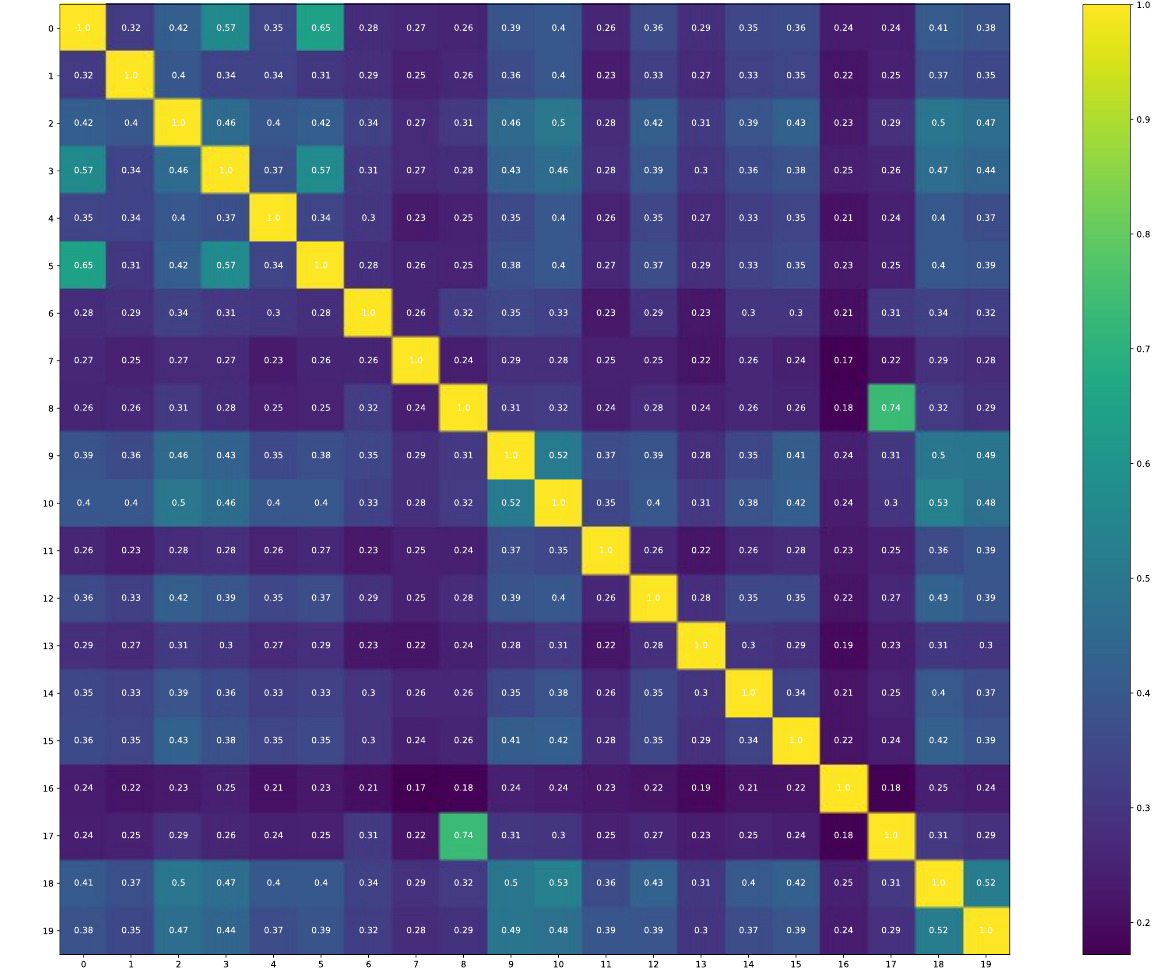
Figure 2. The Tanimoto similarity distribution along with the “to be docked”